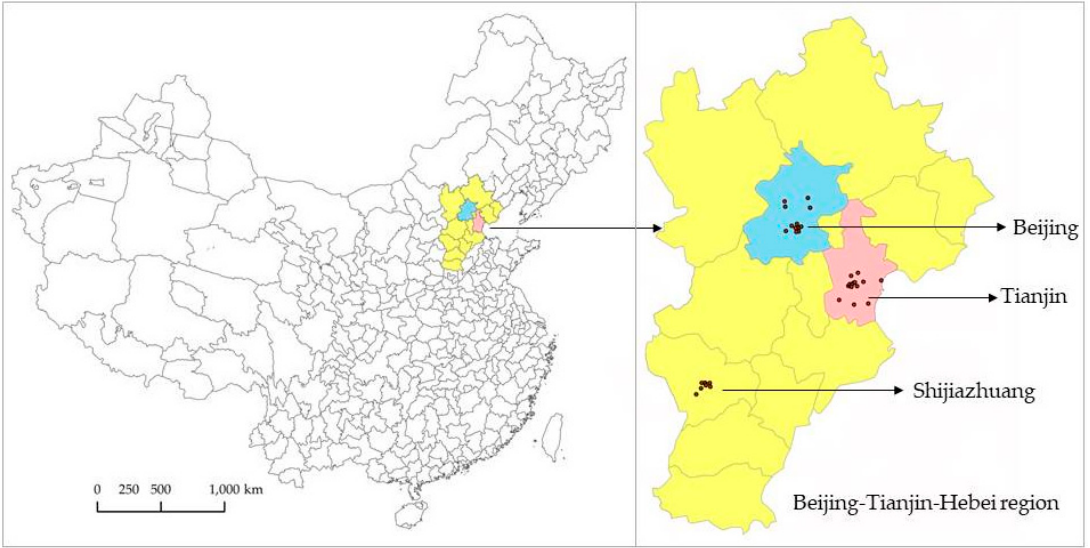
Figure A1. Geo ‐ location of Beijing ‐ Tianjin ‐ Hebei (BTH) region and air quality monitoring stations in Figure A1. Geo-location of Beijing-Tianjin-Hebei (BTH) region and air quality monitoring stations in Beijing, Tianjin and Shijiazhuang (capital of Hebei Province). Beijing, Tianjin and Shijiazhuang (capital of Hebei Province).